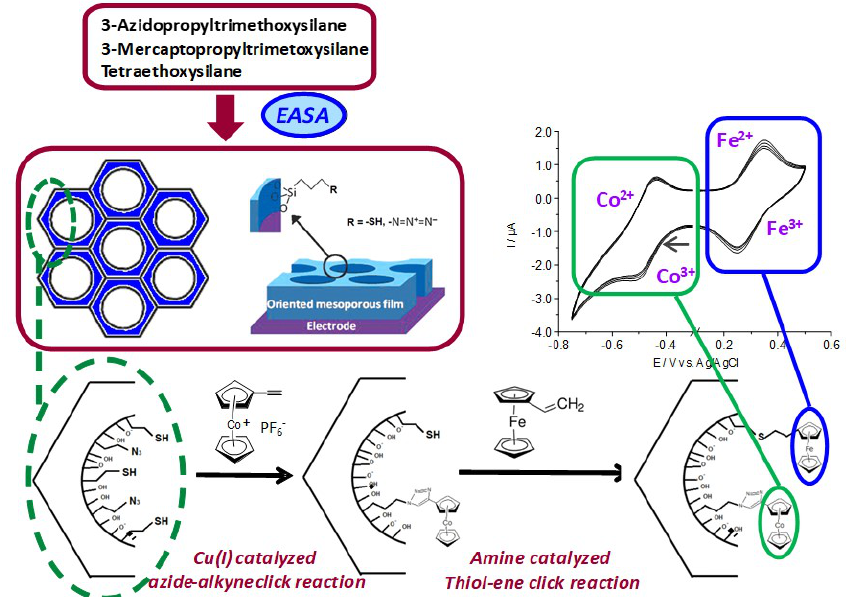
Figure 9. An illustration of the elaboration of oriented azide-thiol-functionalized mesoporous silica film by EASA and subsequent derivatization of azide groups by reaction with an alkyne derivative and the thiol ones with an alkene